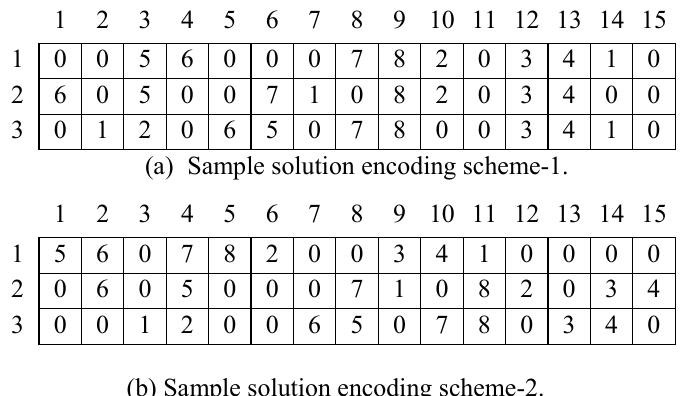
Fig. 2. Solution encoding scheme for proposed SA